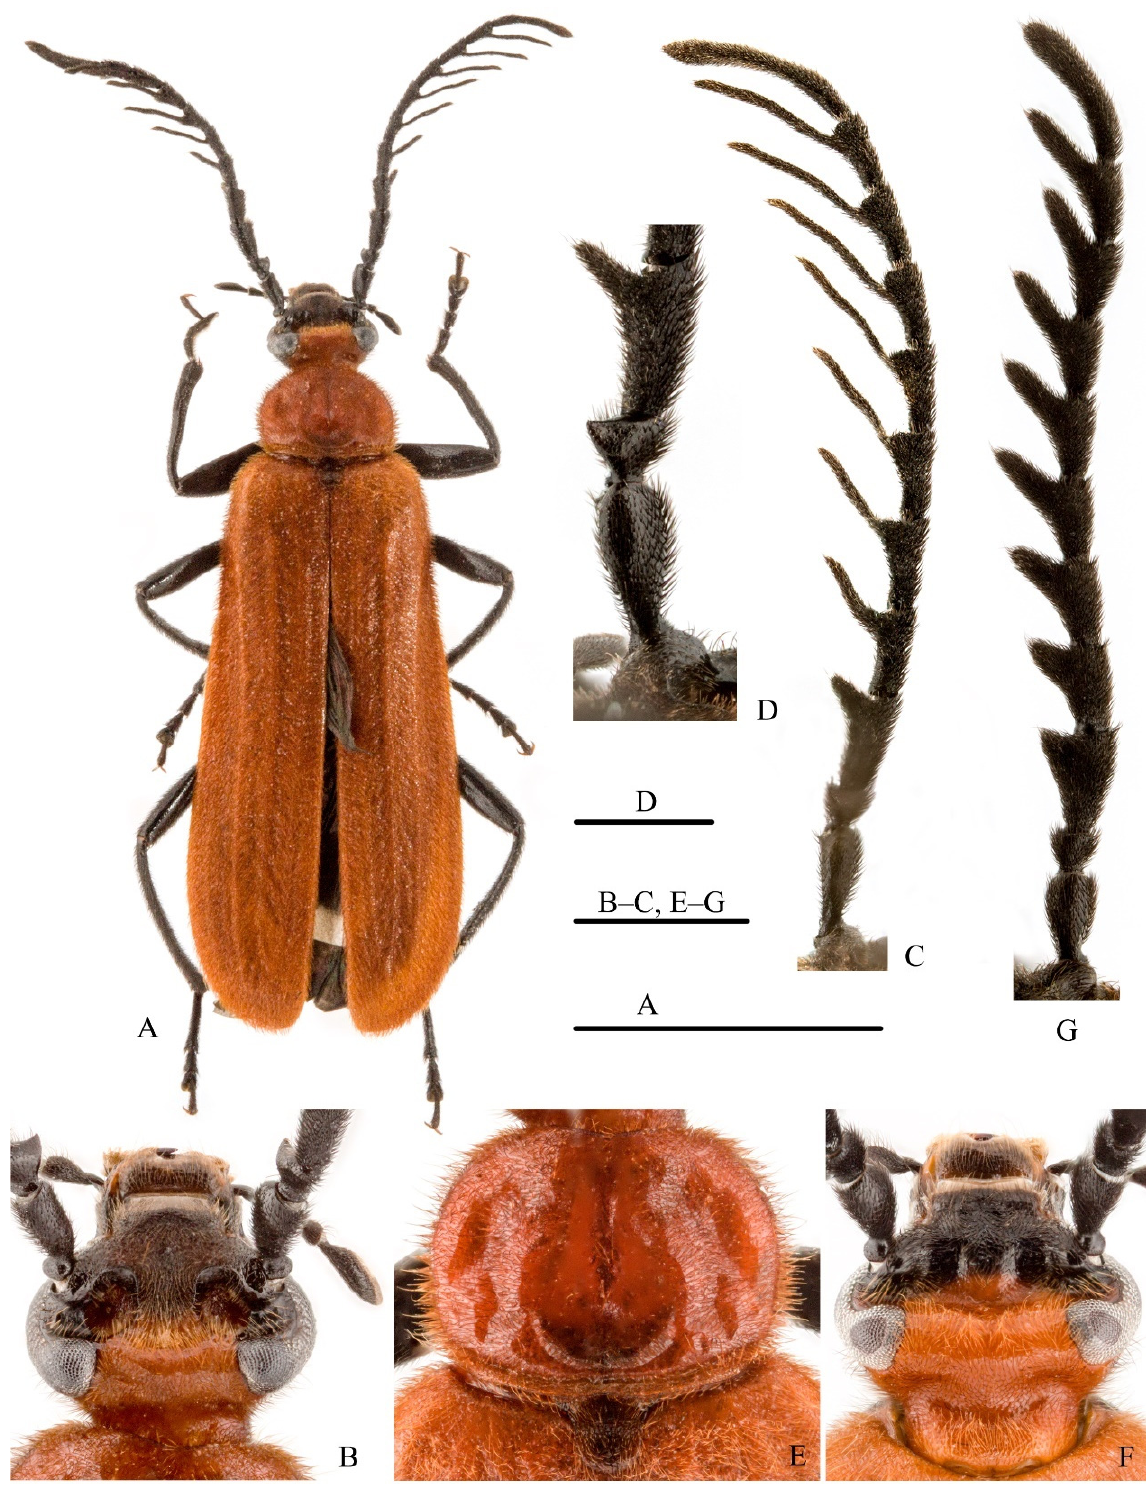
Figure 2. Adult of Pseudopyrochroa reni Pan & Young, n. sp. , paratypes. ( A ) Habitus, male, dorsal view; ( B ) Head, male, dorsal view; ( C ) Antenna, male; ( D ) Antennomeres I–III, male; ( E ) Pronotum and scutellar shield, male; ( F ) Head, female, dorsal view; ( G ) Antenna, female. Scale bars: 5 mm ( A ), 1 mm ( B – C , E – G ), 0.5 mm ( D ). Larva. Anatomically, the mature larva of P. reni n. sp. conforms to the preliminary diagnosis for larvae of Pseudopyrochroa [16,17,37]. The larva of P. reni n. sp. differs from those of other congeners, e.g., P. carinifrons Kôno, 1929, P. depressa Pic, 1914, and P. fainanensis (Pic, 1911) (all distribute in Taiwan, China), by the structure of the urogomphal plate. Mature larvae of P. reni have the lateral lobes of urogomphal plate rounded; the urogomphi are straight and appear slightly divergent, not curved at apex; the urogomphal lip is distinctly visible in dorsal view and widely rounded; the urogomphal pits are deep and without rugulae.